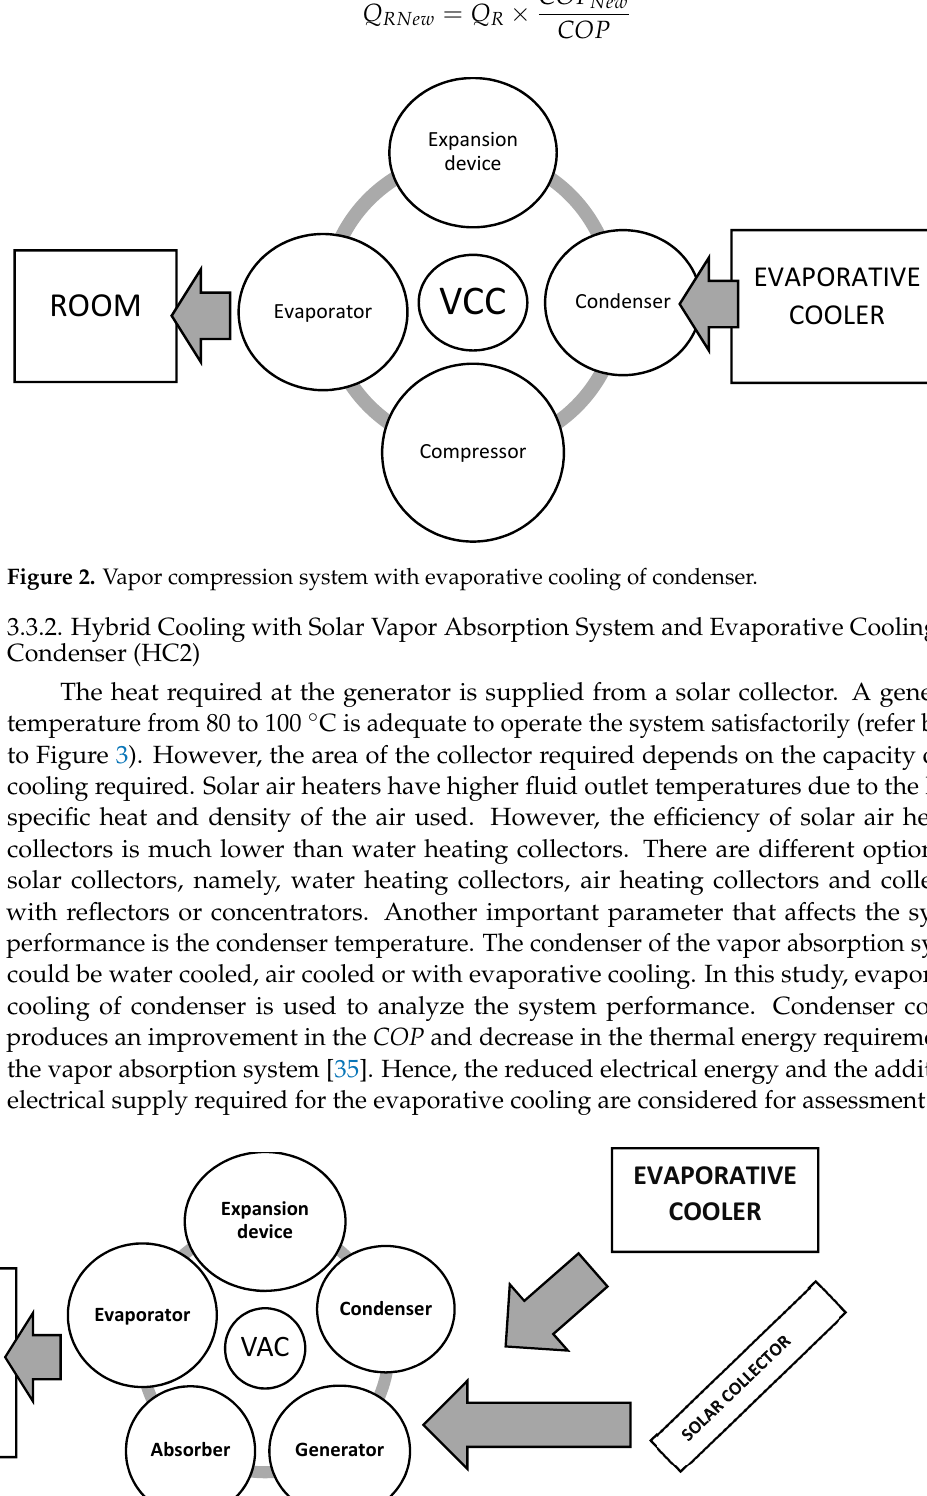
Fig.3 Solar vapor absorption system with evaporative cooling of condenser Figure 3. Solar vapor absorption system with evaporative cooling of